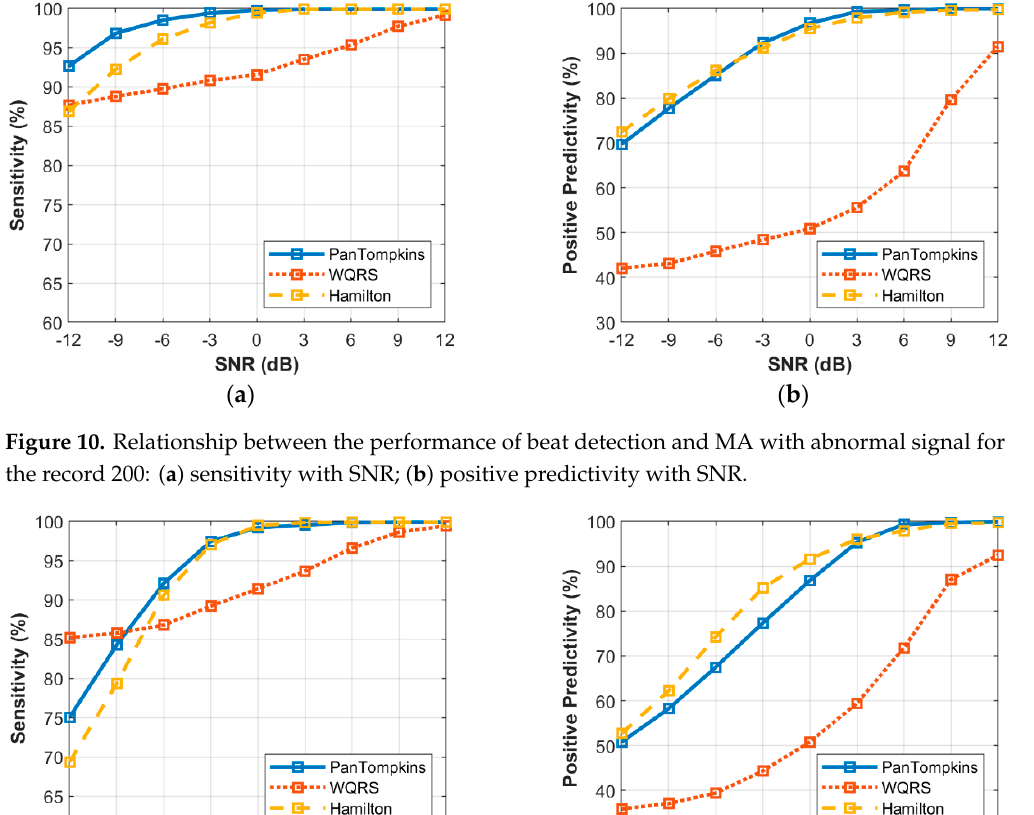
Figure 9. Relationship between the performance of beat detection and BW with abnormal signal for the record 200: ( a ) sensitivity with SNR; ( b ) positive predictivity with SNR.